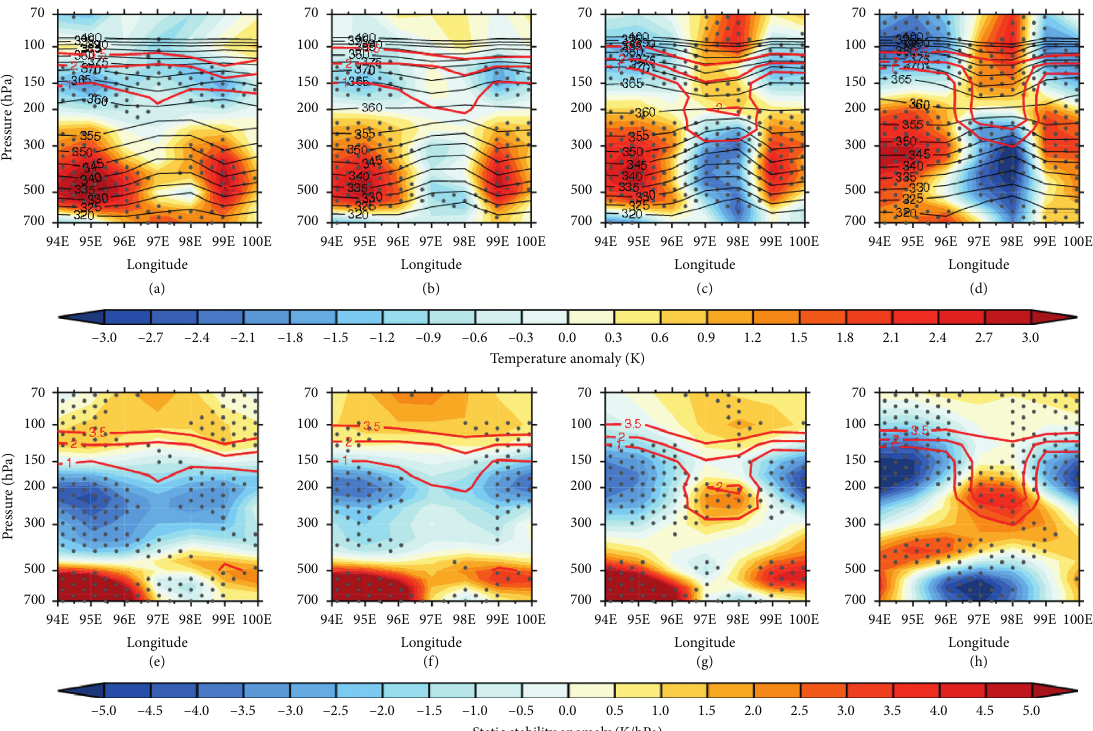
Figure 9: The composites of longitude-pressure cross section of (a, b, c, d) temperature anomaly (units: K, color contours) and potential temperature (units: K, black lines, contour interval: 5 K), and (e, f, g, h) static stability anomaly (units: K/hPa) at 34 ° N for the (a, e) 3rd day, (b, f) 2nd day, (c, g) 1st day, and (d, h) 0 day before the OCS onset for 41 OCS events. The black dotted areas indicate that the anomalies are statistically significant at a 95% confidence level (based on a two-sided Student’s t -test). The red lines show the contours of 1, 2, and 3.5PV